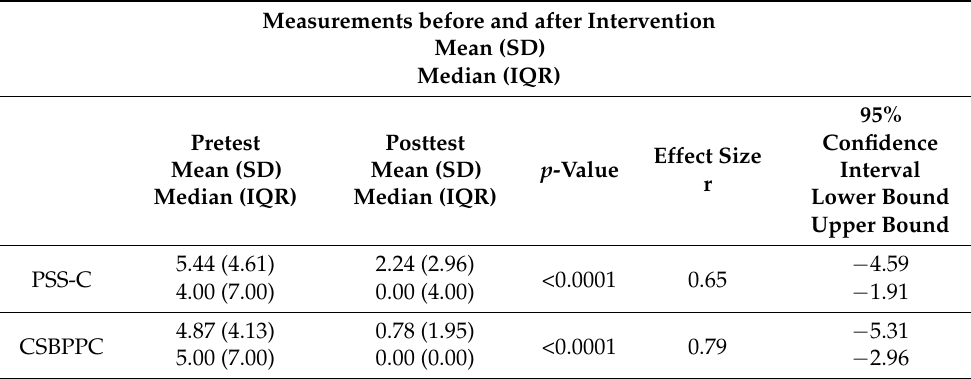
95% Confidence Effect Size Interval Lower Bound